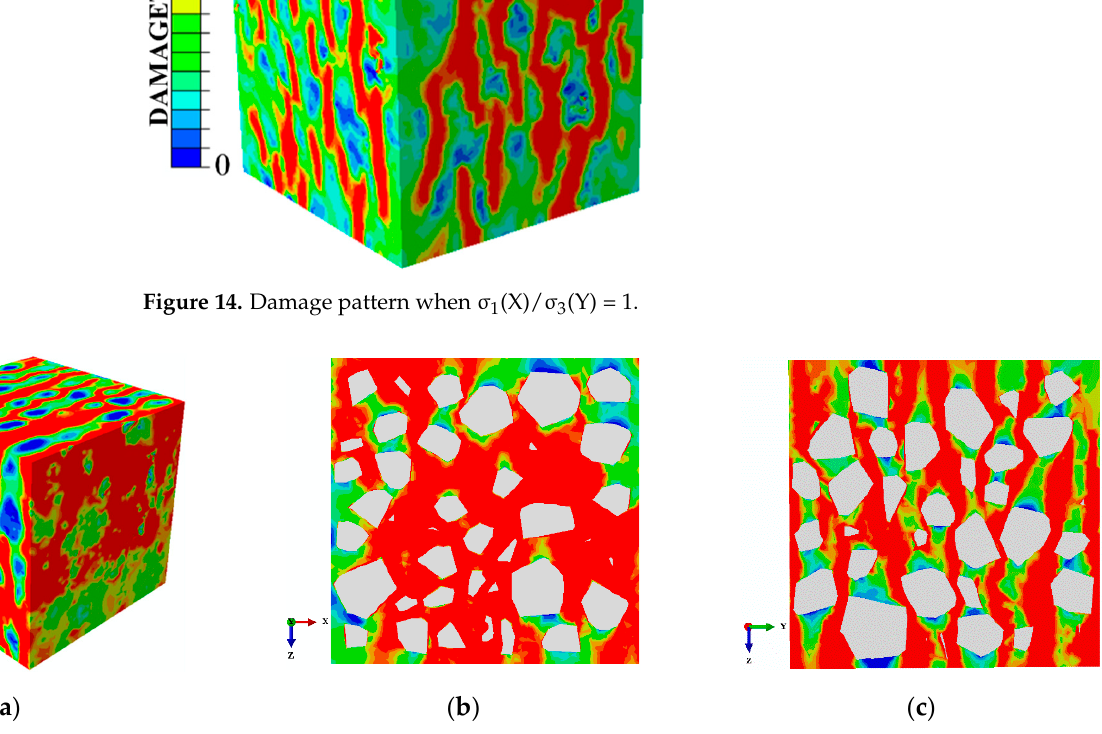
Figure 15. Damage feature when ( σ 1 (X)/f c )/( σ 3 (Y)/f c ) = 5: ( a ) a view of the whole specimen, ( b ) a view of the X-Z plane and ( c ) a view of the Y-Z plane.